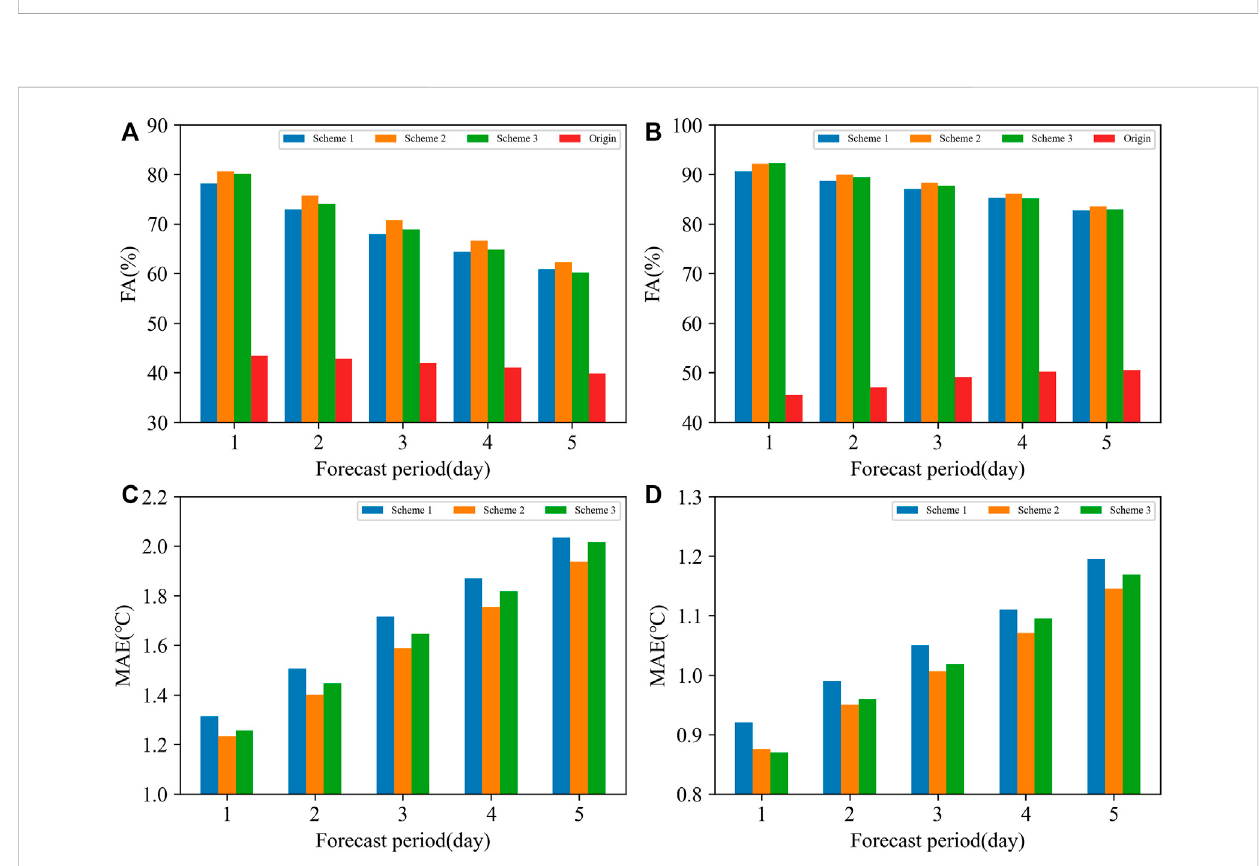
are grouped for separate modeling correction, and the remaining samples are grouped as another group. The exhaustive method is used for the cloud cover threshold, starting from 0% total cloud cover as the threshold, increasing to 100% at 5% intervals; 21 cloud cover values were selected as grouping thresholds for correction. Scheme 3: Grouping by low cloud cover, the temperature forecast samples with cloud cover less than the speci fi ed